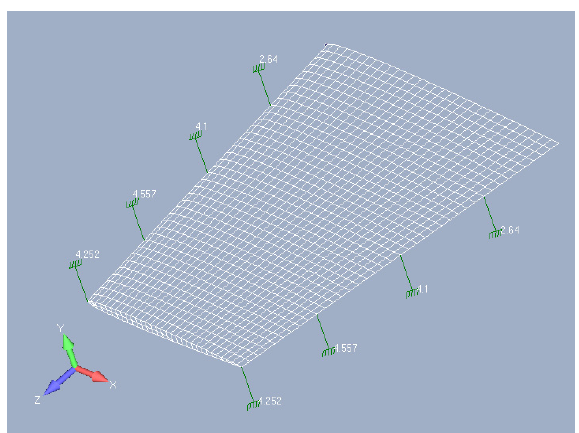
Figure 7. Section rotational displacement field boundary condition (solid airfoil cross-section)